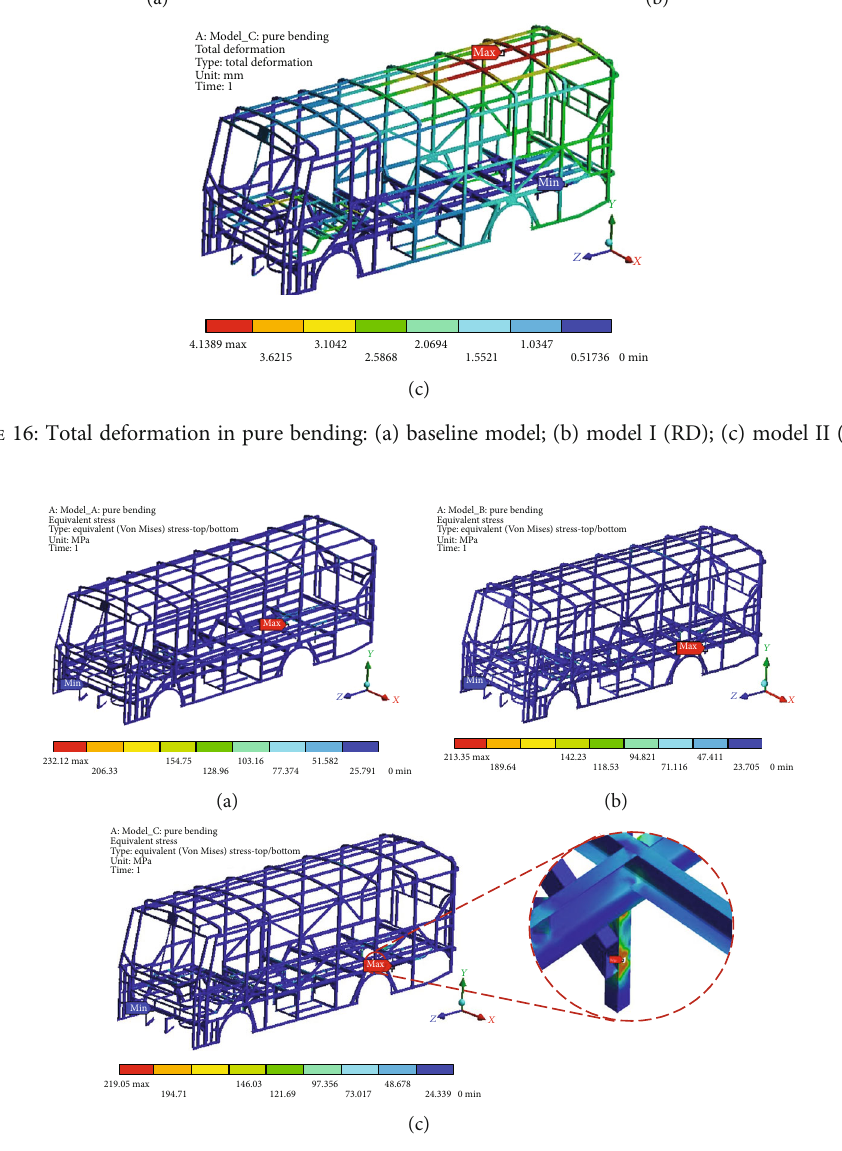
Figure 17: Equivalent stress in pure bending: (a) baseline model; (b) model I (RD); (c) model II